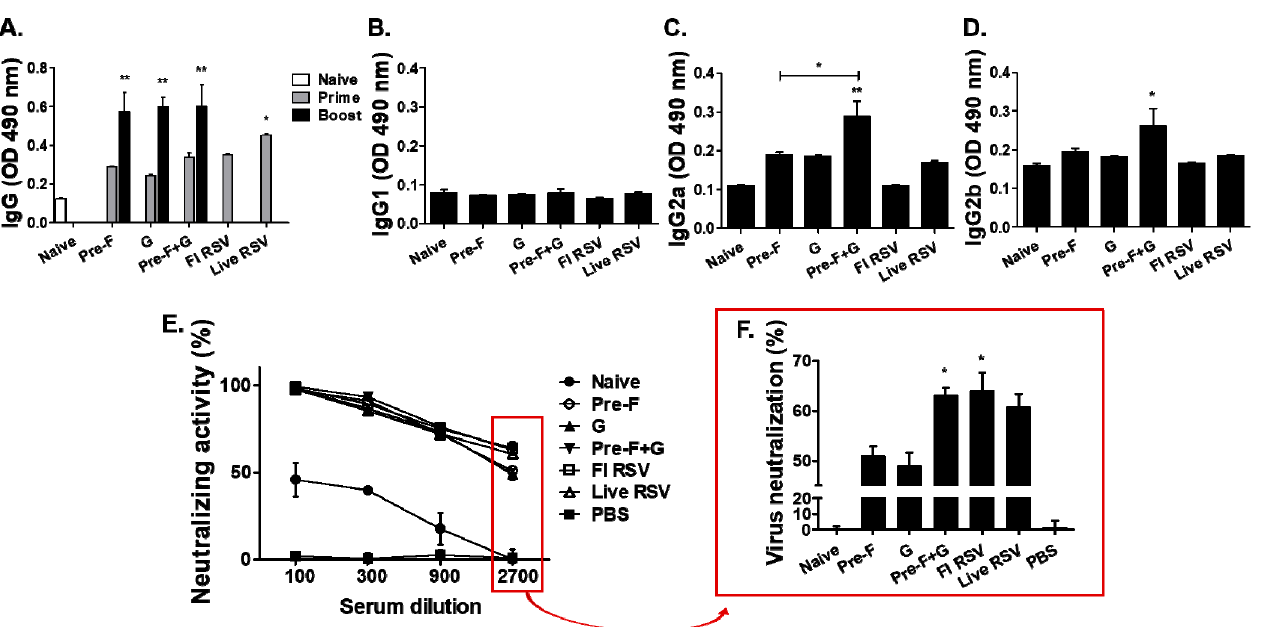
Figure 2. Serum antibody responses and neutralizing activity. RSV A2-specific IgG ( A ) antibody response was determined in the sera (n = 6) at week 3 after prime (gray bars) and boost (black bars) immunization. RSV A2-specific IgG1 ( B ), IgG2a ( C ), and IgG2b ( D ) antibody responses were observed in the sera (n = 6) at week 3 after boost immunization. A higher level of IgG antibody response was determined in immunized mice compared to naïve mice (( A ), * p < 0.05, ** p < 0.01). A higher level of IgG2a antibody responses was determined in Pre-F+G VLPs immunized mice compared to naïve, FI-RSV, and Live RSV groups (( C ), ** p < 0.01, * p < 0.05). In addition, a higher level of IgG2b antibody response was detected in the Pre-F+G VLPs group compared to the naïve group (( D ), * p < 0.05). A dose-dependent relationship between serum dilution and virus neutralization activity was observed ( E ). Neutralizing antibody response exceeding 50% virus neutralization was detected until 2700-fold serum dilution, and Pre-F+G VLP-immunized mice showed significantly higher neutralizing responses than Pre-F VLPs immunized mice (( F ), * p < 0.05).